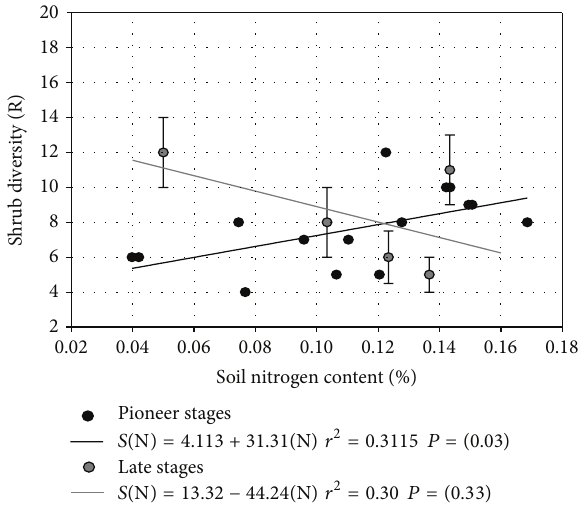
Figure 4: The relationships between shrub diversity and soil nitro- gen content in the Tamaulipan thornscrub forests of northeastern Mexico.